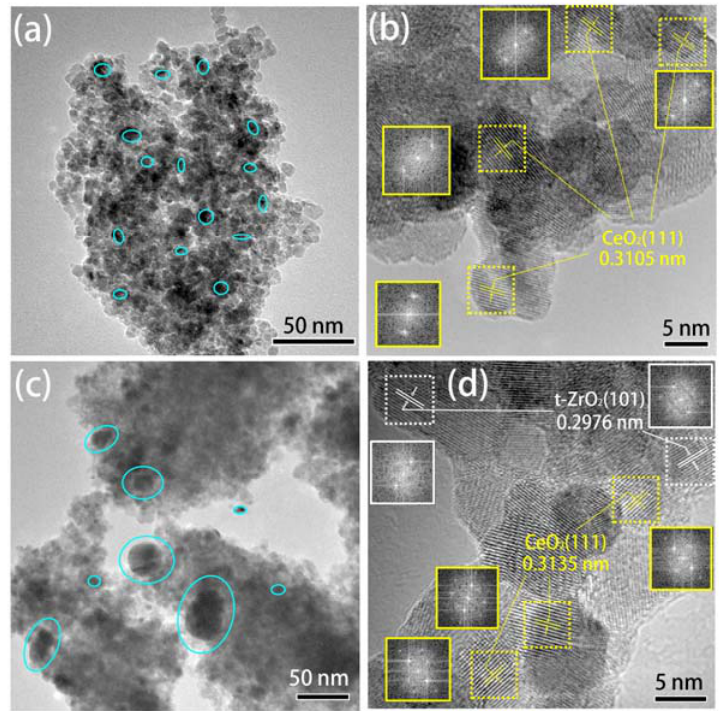
Figure 3. TEM image of the Au-CeZr-15 ( a , b ) and Au-CeZr-45 ( c , d ) catalysts. The insets are Fast Fourier transform (FFT) images of square region (dot line). The d -spacing (nm) are calculated from FFT.